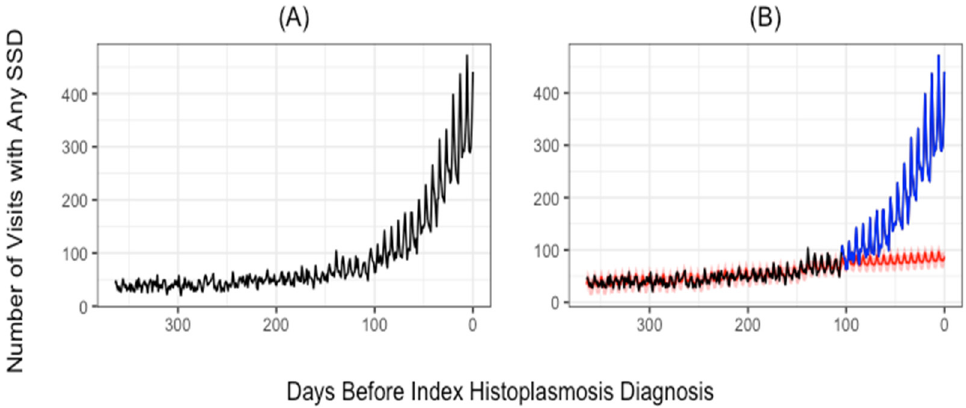
Figure 1. Trends in observed and expected number of symptomatically similar diagnoses (SSD)- related visits. The number of visits with any SSD-related diagnosis (vertical axis) is plotted for the number of days prior to the index histoplasmosis diagnosis (horizontal axis). Observed SSD-related visits are given in panel ( A ). In panel ( B ), the red line was estimated using the data collected before the change point and gives the trend in expected visits. The blue line represents the actual number of visits after the change point. Possible diagnostic opportunities are represented by the area between the blue line and the red line.